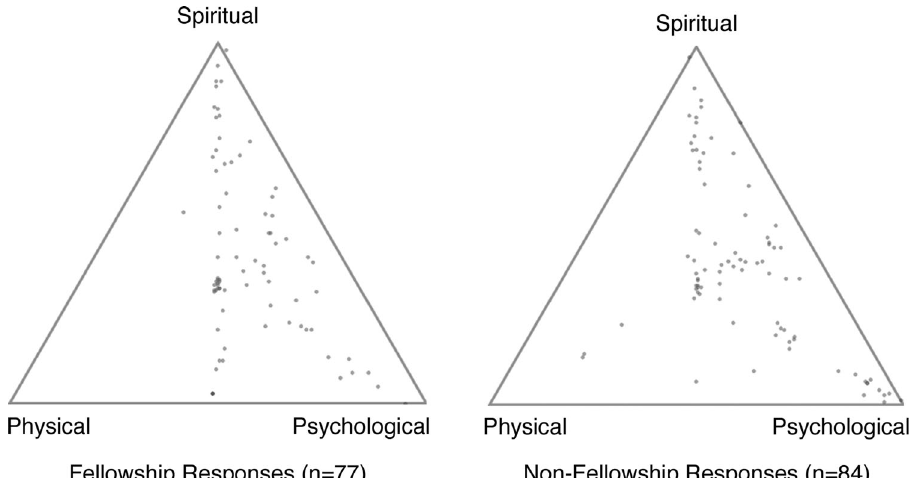
Fig. 4 Responses for Triad